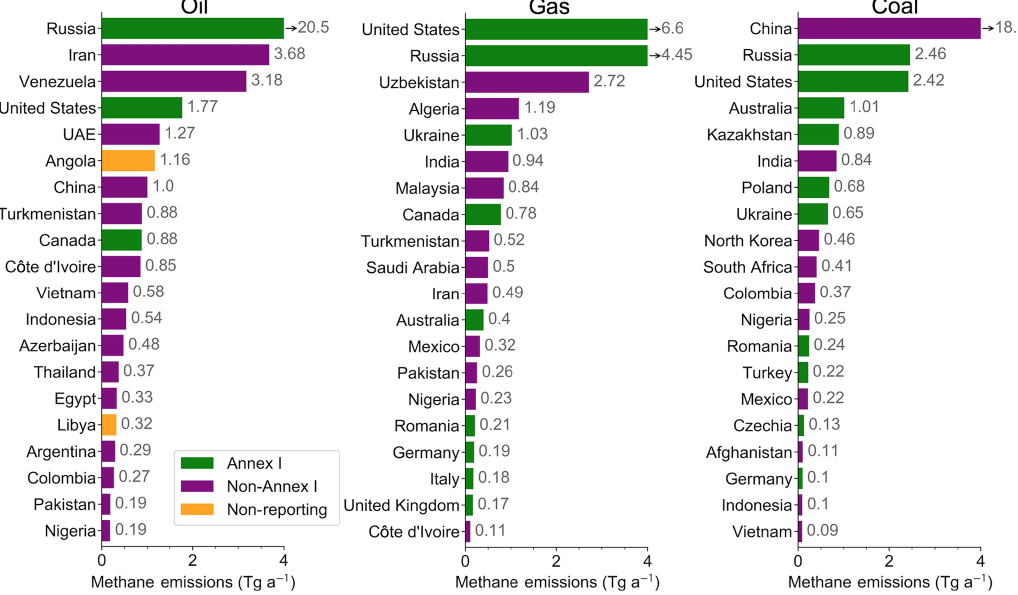
Figure 3. Methane emissions in 2016 from the top 20 emitting countries for the oil, gas, and coal sectors. Arrows next to the top bars (highest emitting countries) indicate that emissions are not to